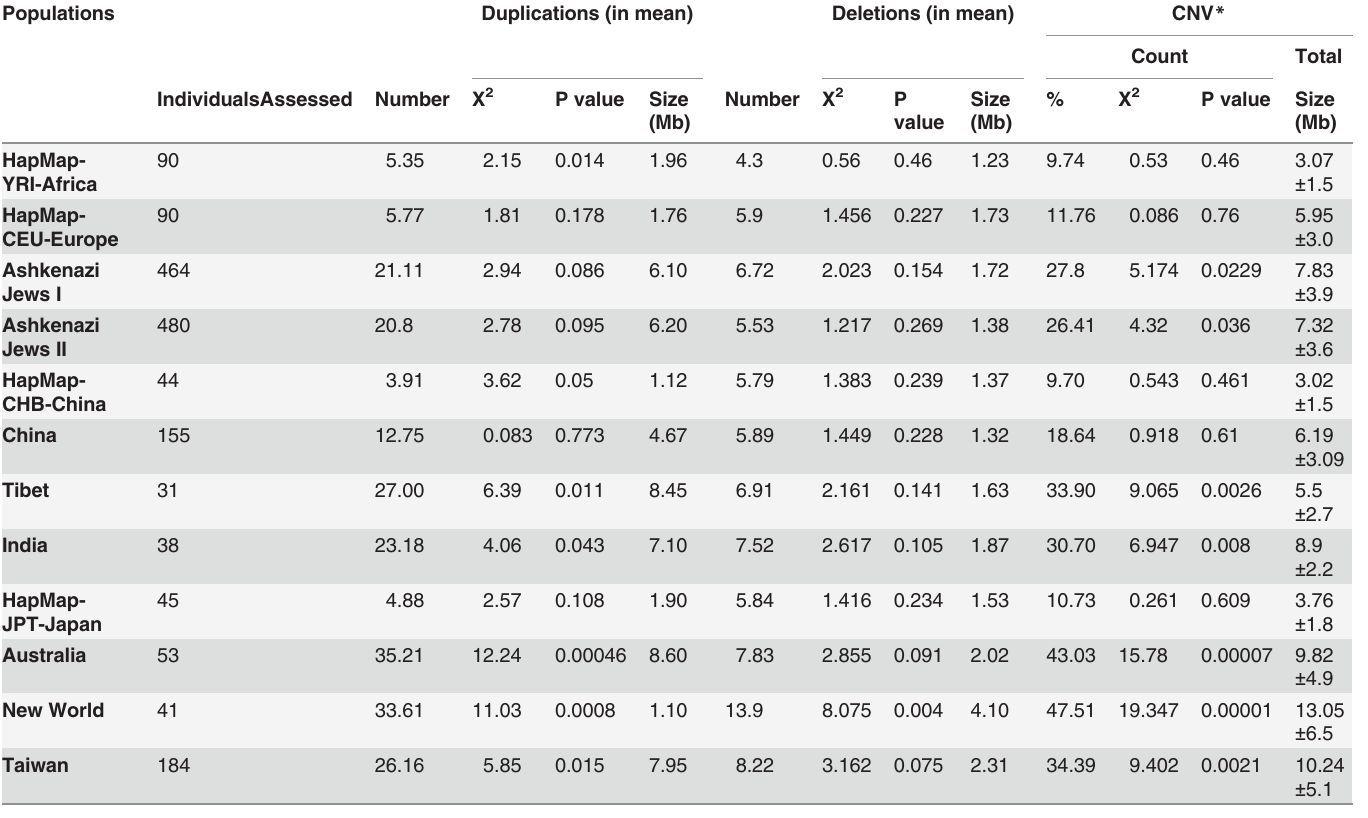
Table 1. Genome-wide distribution of duplication and deletion CNVs across 12 populations. Populations Duplications (in mean) Deletions (in mean)